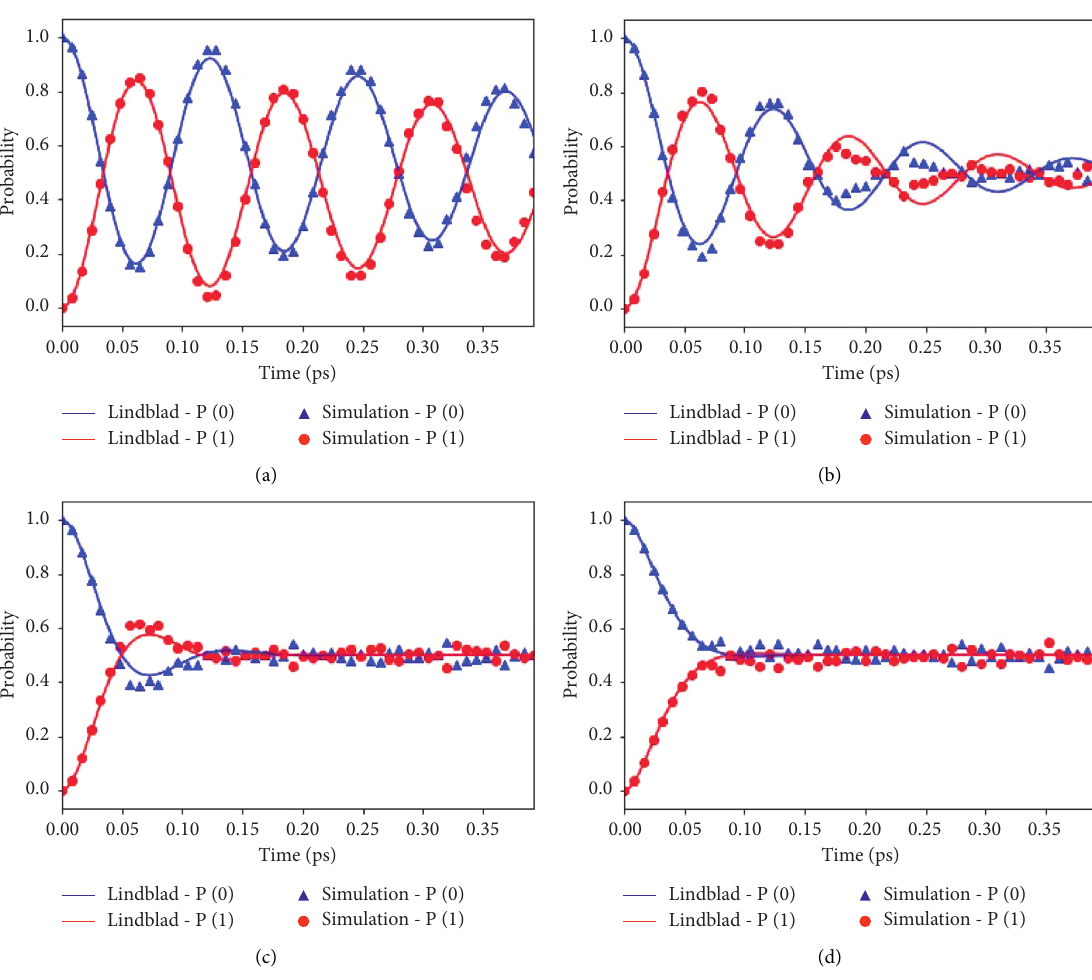
Figure 7: Evolution dynamics of the system with decoherence obtained by employing the quantum algorithm for the near-resonant system: simulation results (points) and theory (lines). (a) g � 1000 cm − 1 ; c deph � 2.3THz. (b) g � 300 cm − 1 ; c deph � 10THz. (c) g � 700 cm − 1